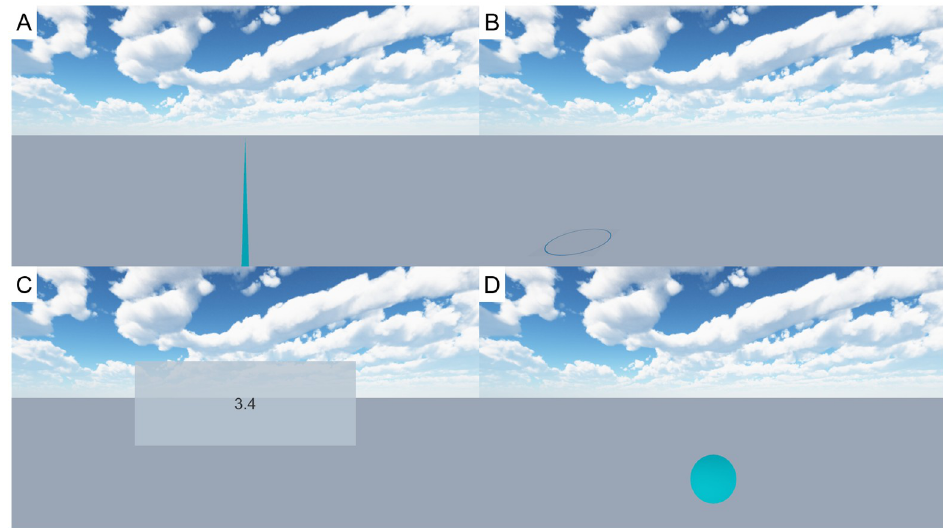
Fig 2. Measuring methods. Depending on the measuring approach, additional content was displayed after the environment was switched off. (A) An orientation line was displayed to guide the direction during visually guided walking. (B) The participant was asked to step into the circle for blind triangulated pointing. (C) A GUI displayed the participant’s verbal estimate after it was entered via a keyboard by the experimenter. (D) The virtual ball the participant had to throw for virtual throwing was also visible during the